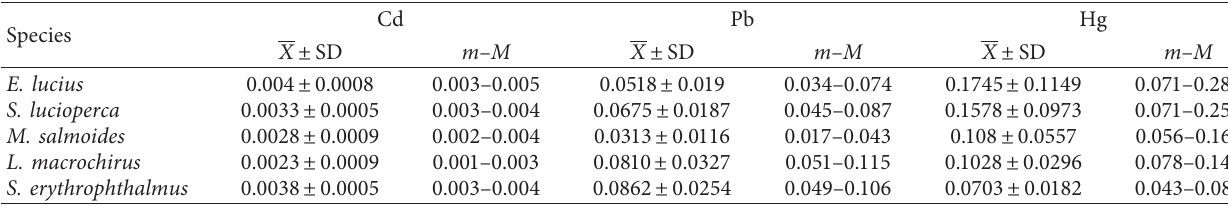
Table 4: Contents of trace metals dosed in the muscles of fish species collected from the Mechraˆa-Hammadi Dam (mg/kg of wet weight).